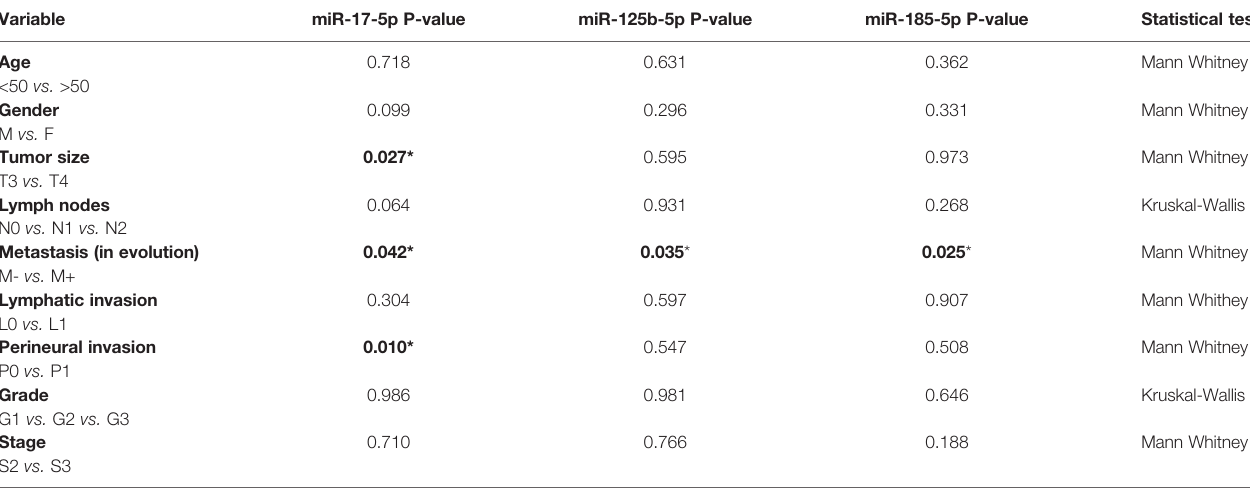
TABLE 3 | Relation of clinicopathological data and miRNA expression while comparing patients with and without metastases in the tissue study. Variable Statistical test Age <50 vs. >50 Gender M vs. F Tumor size T3 vs. T4